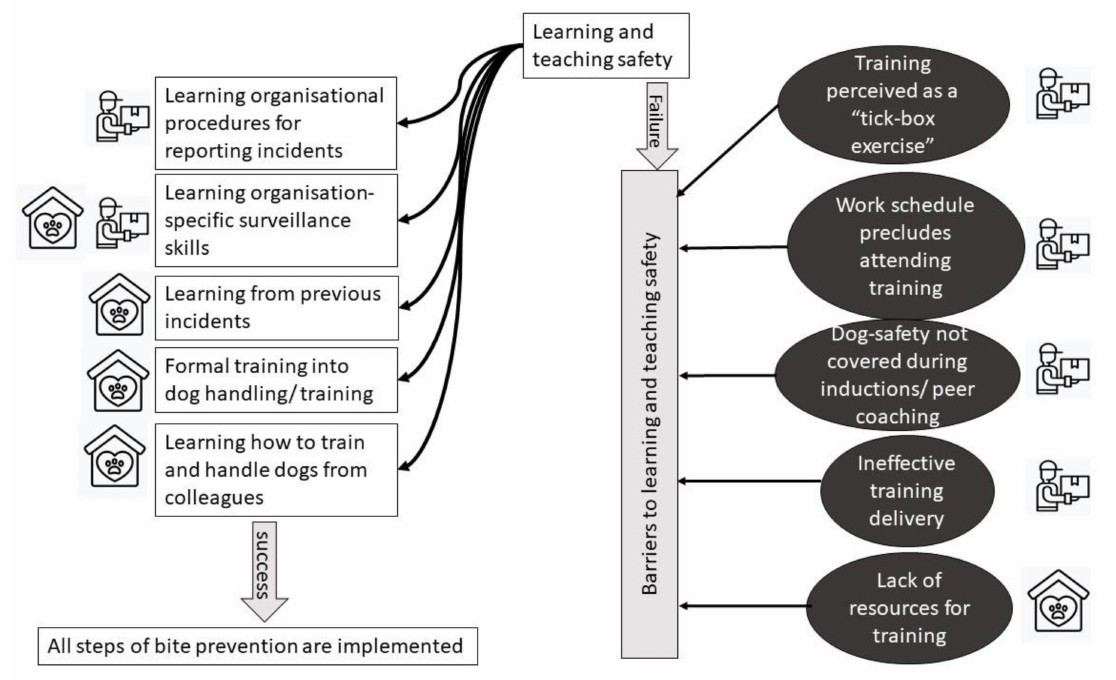
Figure 7. Schematic representation of learning and teaching safety. In both organisations, learning requires understanding organisaional surveillance mechanism. Multiple ways of learning have been identified. Barriers to learning/ teaching safety were